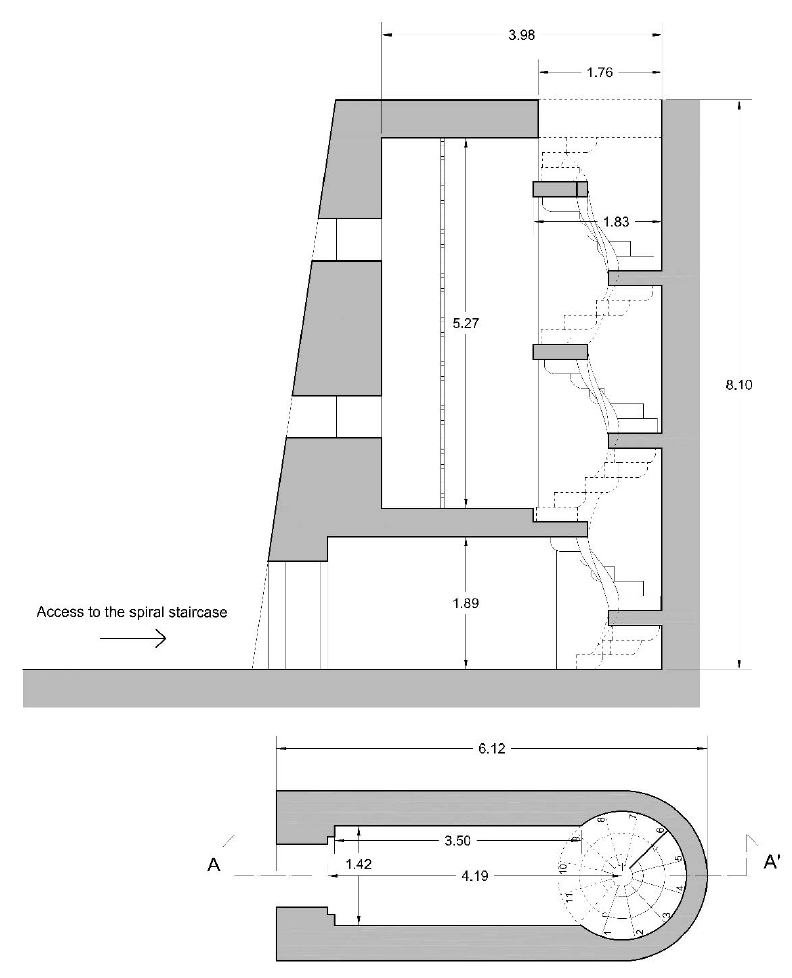
Figure 4. Spiral staircase in the tower of Nisida: plan and section (Unit: m). Survey and drawings by the authors.